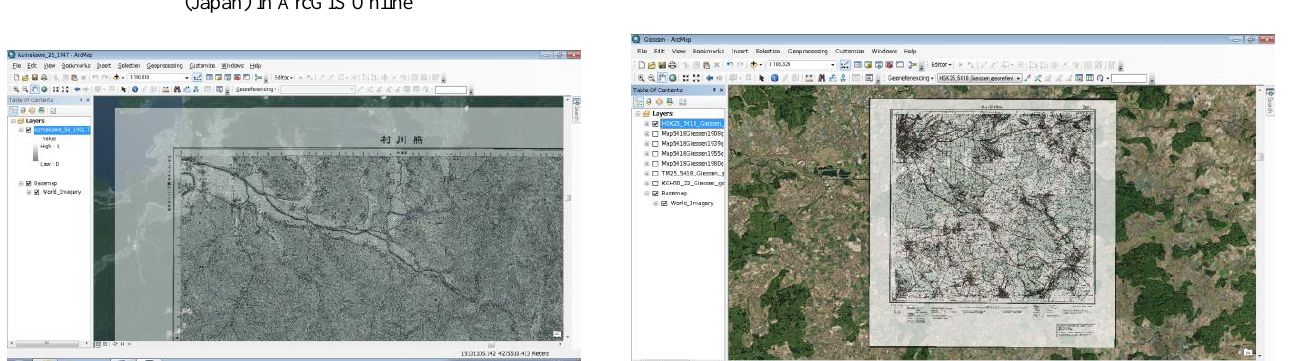
Figure 17. Overlay of Old Edition Map: Topographic Map (Japan) in ArcGIS Online with 30% transparancy